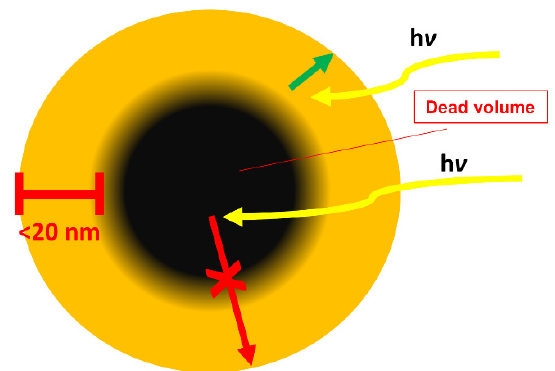
Figure 34. Dead volume within a polymer photocatalyst particle. Exciton diffusion lengths are limited to <20 nm which means that those created deeper within the particle are not able to reach the surface and thus do not contribute to the materials’ activity.